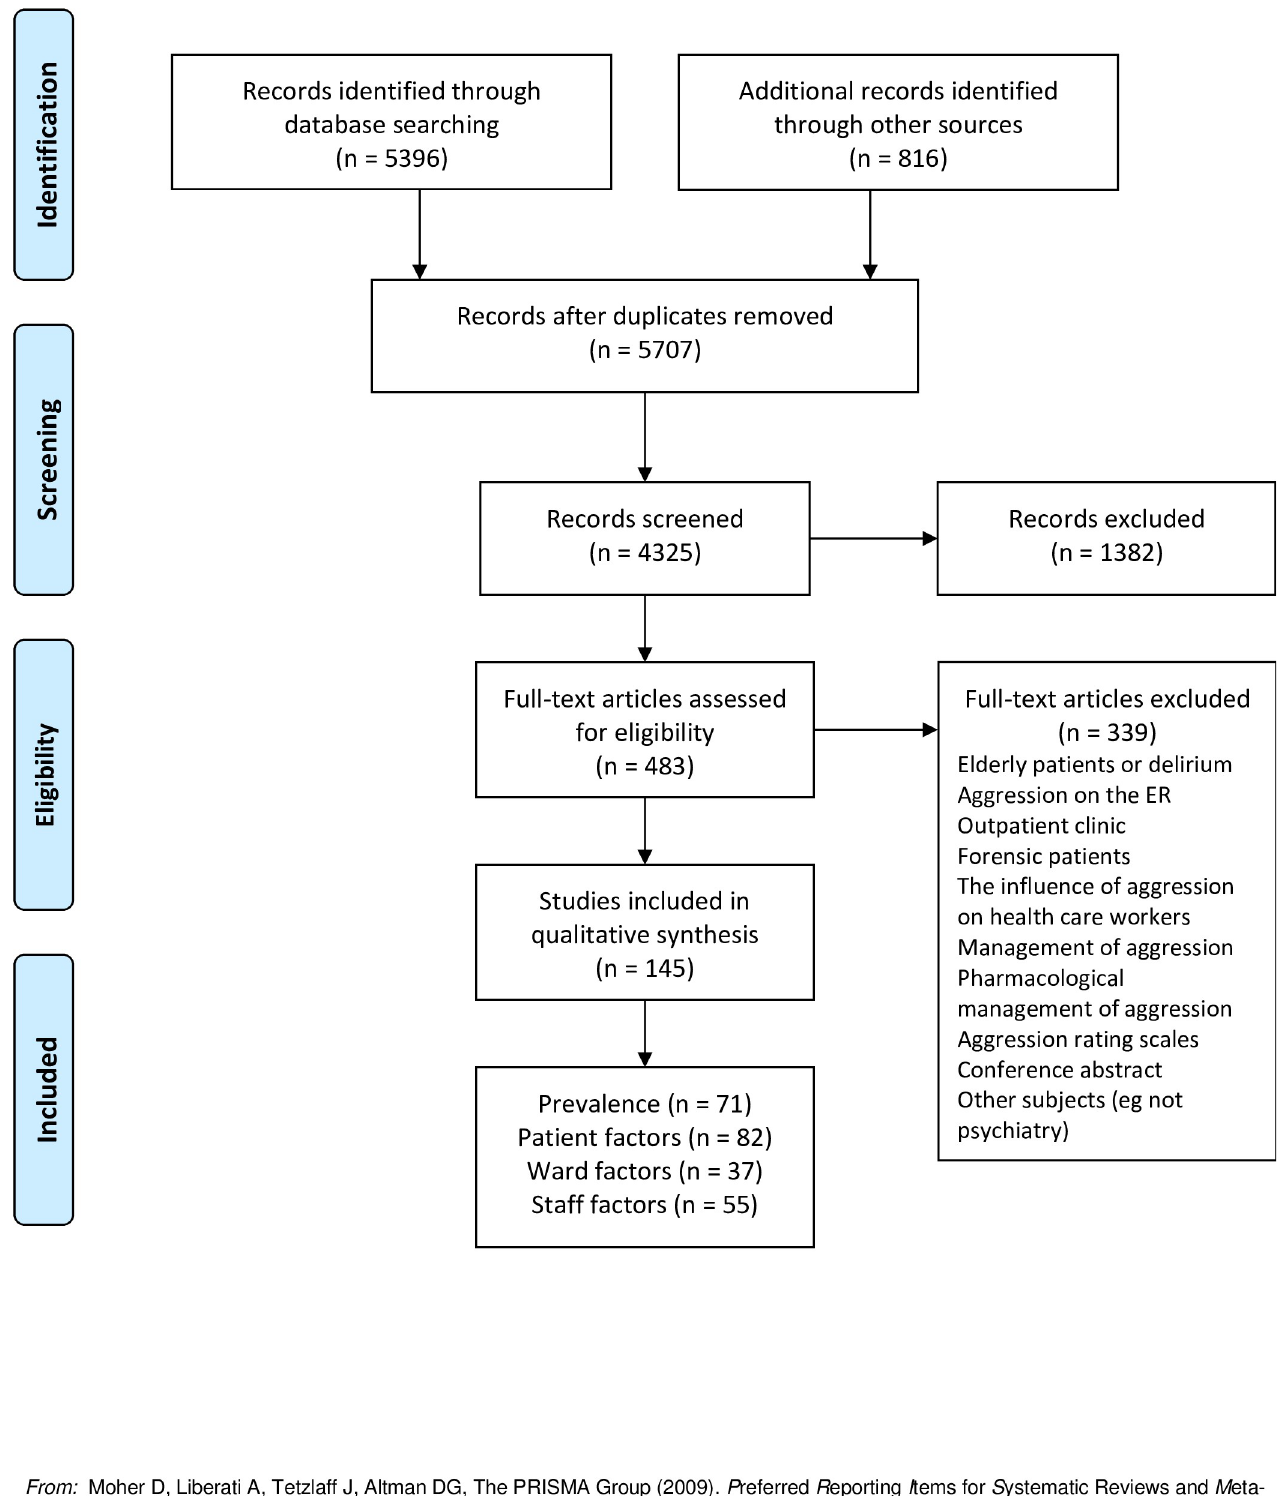
Fig 1. PRISMA flow diagram. https://doi.org/10.1371/journal.pone.0258346.g001 PLOS ONE | https://doi.org/10.1371/journal.pone.0258346 October 8,